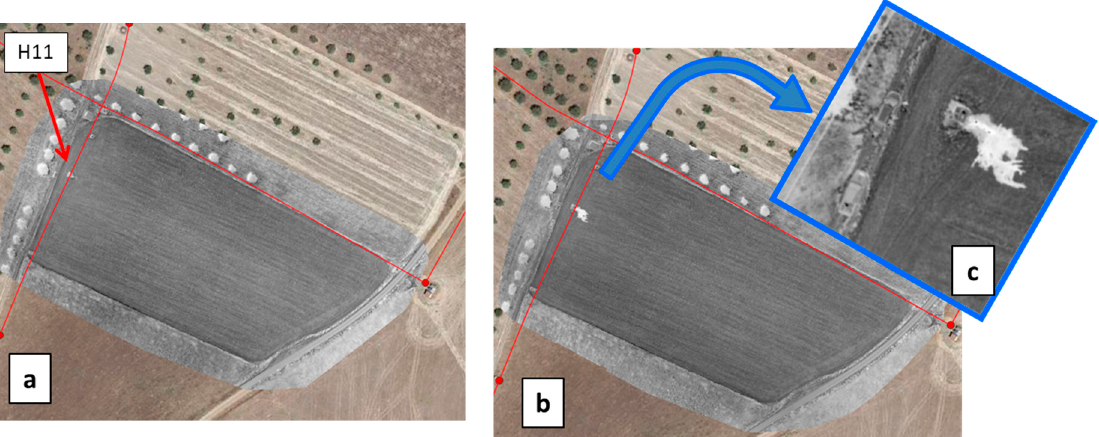
Figure 13. WI images obtained with the UAV on 14 May 2019 over the test field containing hydrant H11, ( a ) before and ( b ) after the vane was opened to simulate a leak; ( c ) is a close ‐ up over the hydrant area. The WI images are in greyscale (white for wet and black for dry), the water network is overlaid in red and Goggle Earth data (in color) fill the surrounding area. Covered area is about 130 m × 240 m. The contrast between wet and dry soil is very high.